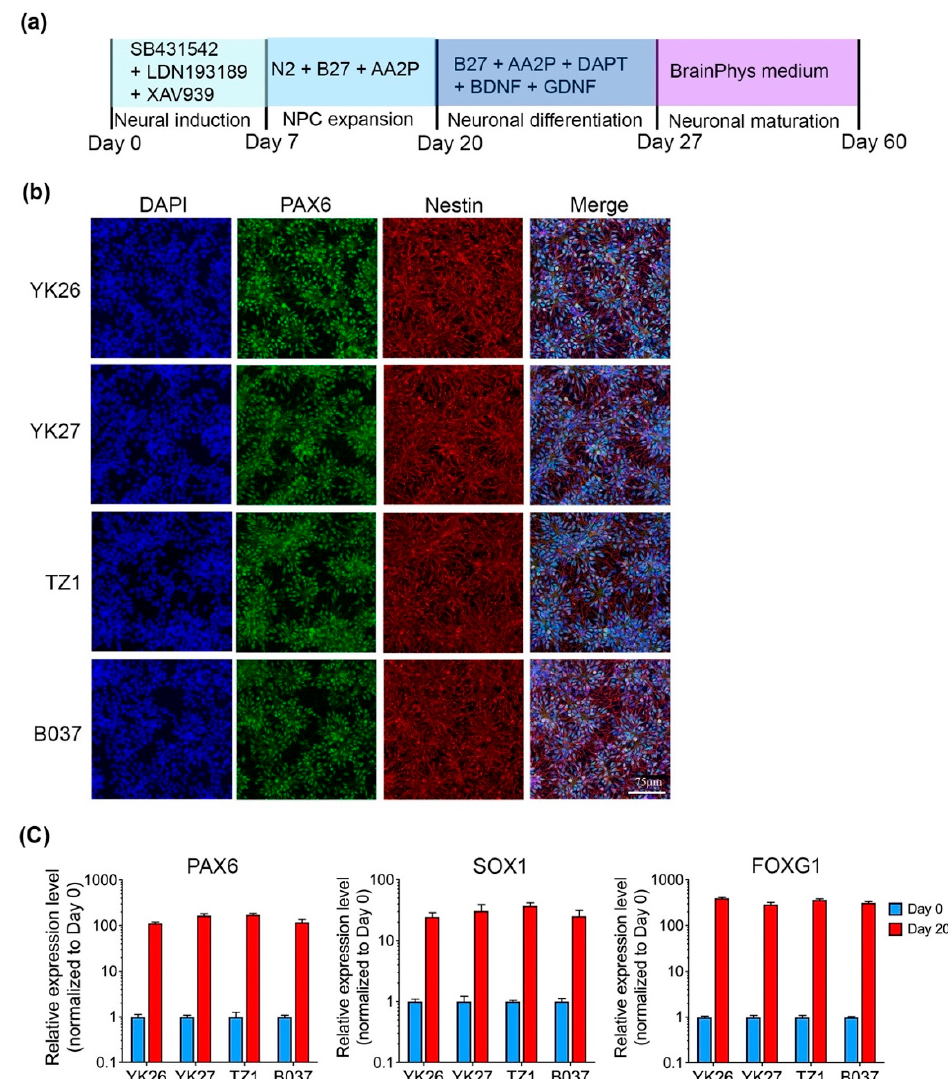
Figure 1. Differentiation of iPSCs into Neural progenitor cells (NPCs). ( a ) Scheme of neuronal differentiation protocol. ( b ) Cells derived from four iPSC lines are confirmed as NPCs on day 20, showing immunopositive staining for neural stem cell makers: Nestin and PAX6. White scale bar, 75 μ m. ( c ) PAX6 , SOX1 , and FOXG1 genes are highly expressed in NPCs as assessed by qRT-PCR. n = 4 experiments for each line were repeated independently, data are presented as mean ± standard error of mean (SEM).